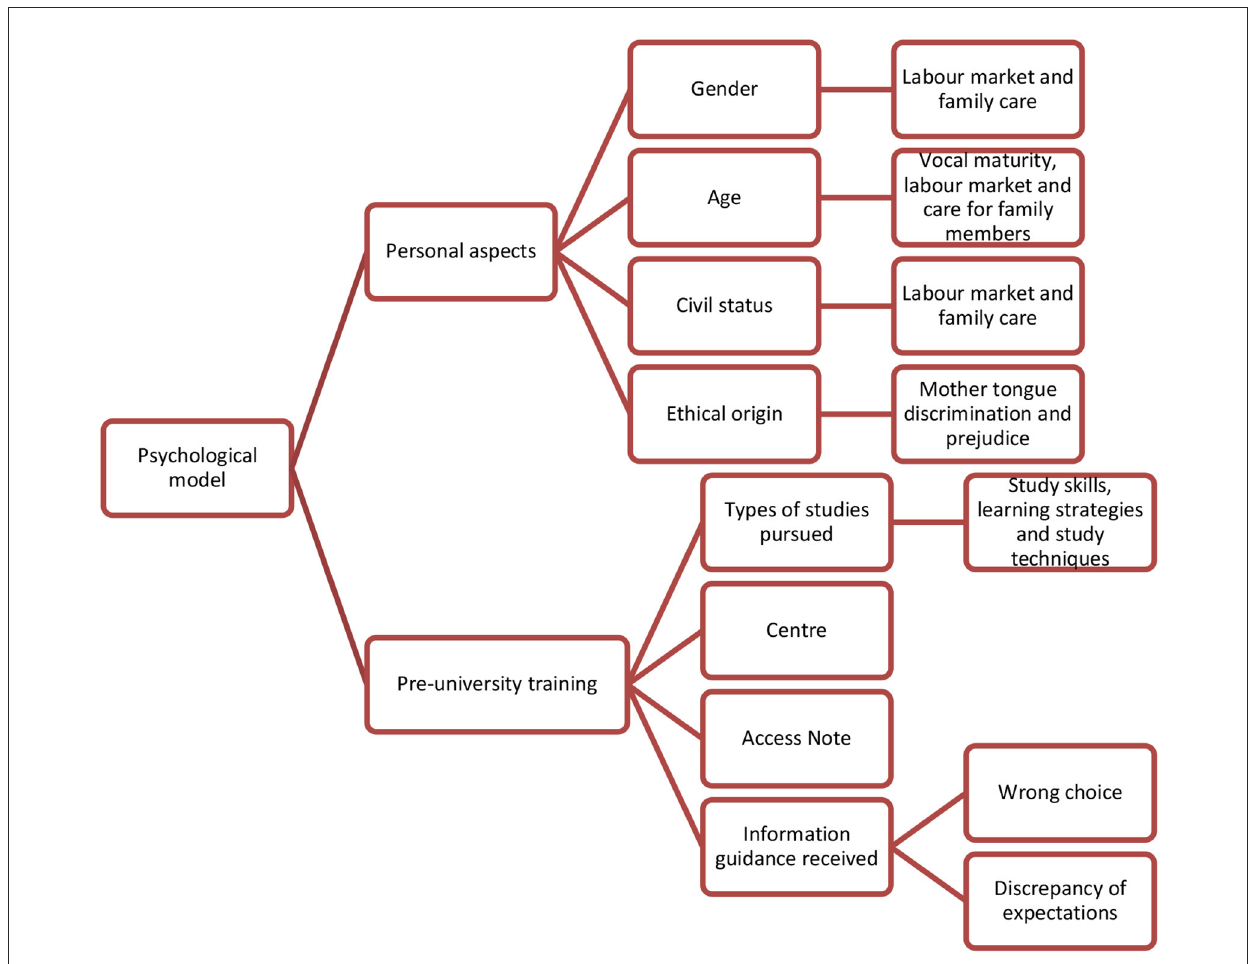
FIGURE2 Personal and pre-university variables that make up the psychological model of university dropout. Based on Pedraza (2021).